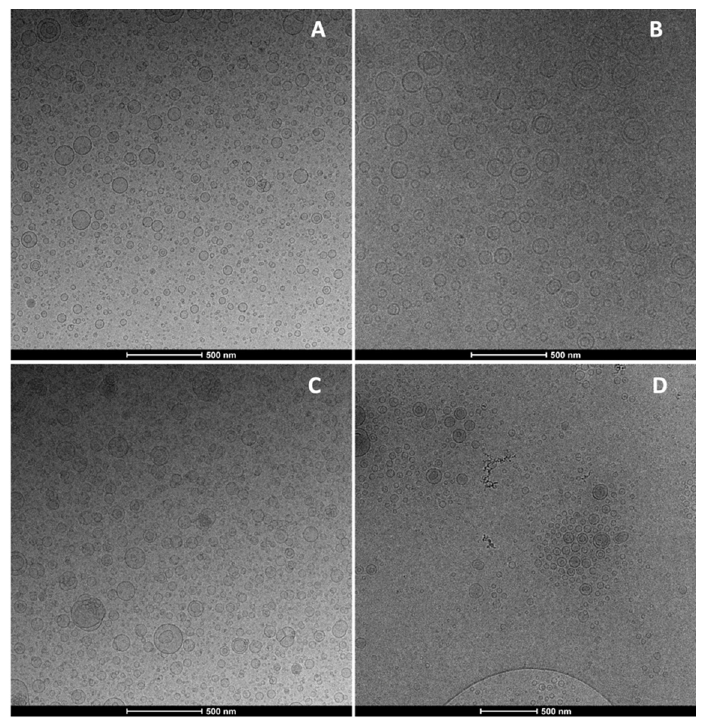
Figure 1. Representative Cryo-TEM images of beclomethasone dipropionate loaded liposomes ( A ),